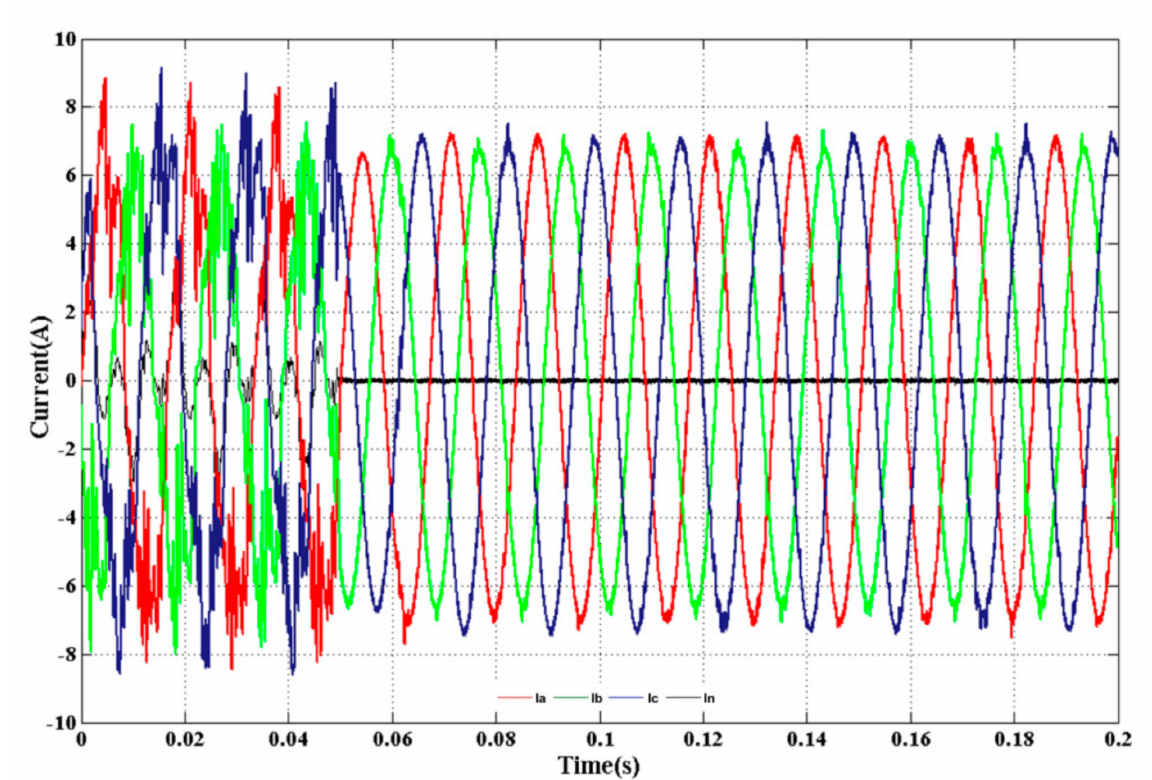
Figure 20. Experimental result of the FNN for case